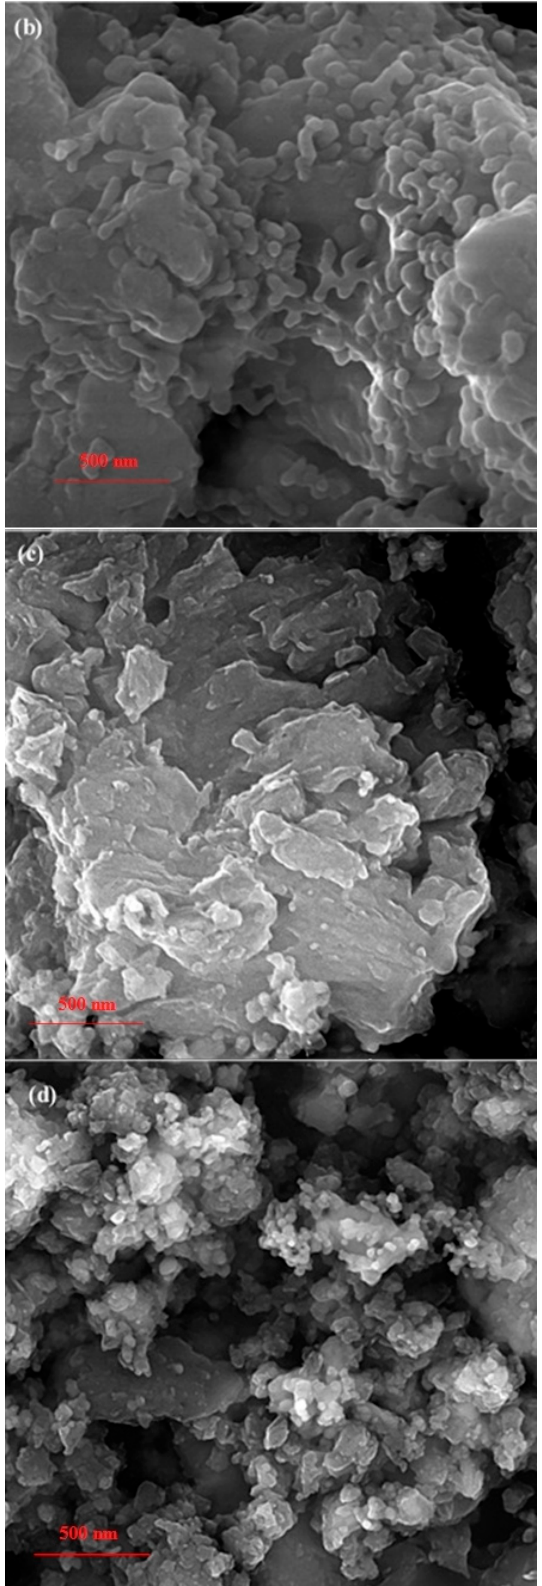
Figure 10. FESEM images of: ( a ) used Ca ‐ 9Co after reduction step; ( b ) regenerated Ca ‐ 9Co after calcination/oxidation step; ( c ) used Ca ‐ 9Co ‐ 4.5Y after reduction step; and ( d ) regenerated Ca ‐ 9Co ‐ 4.5Y after calcination/oxidation step.